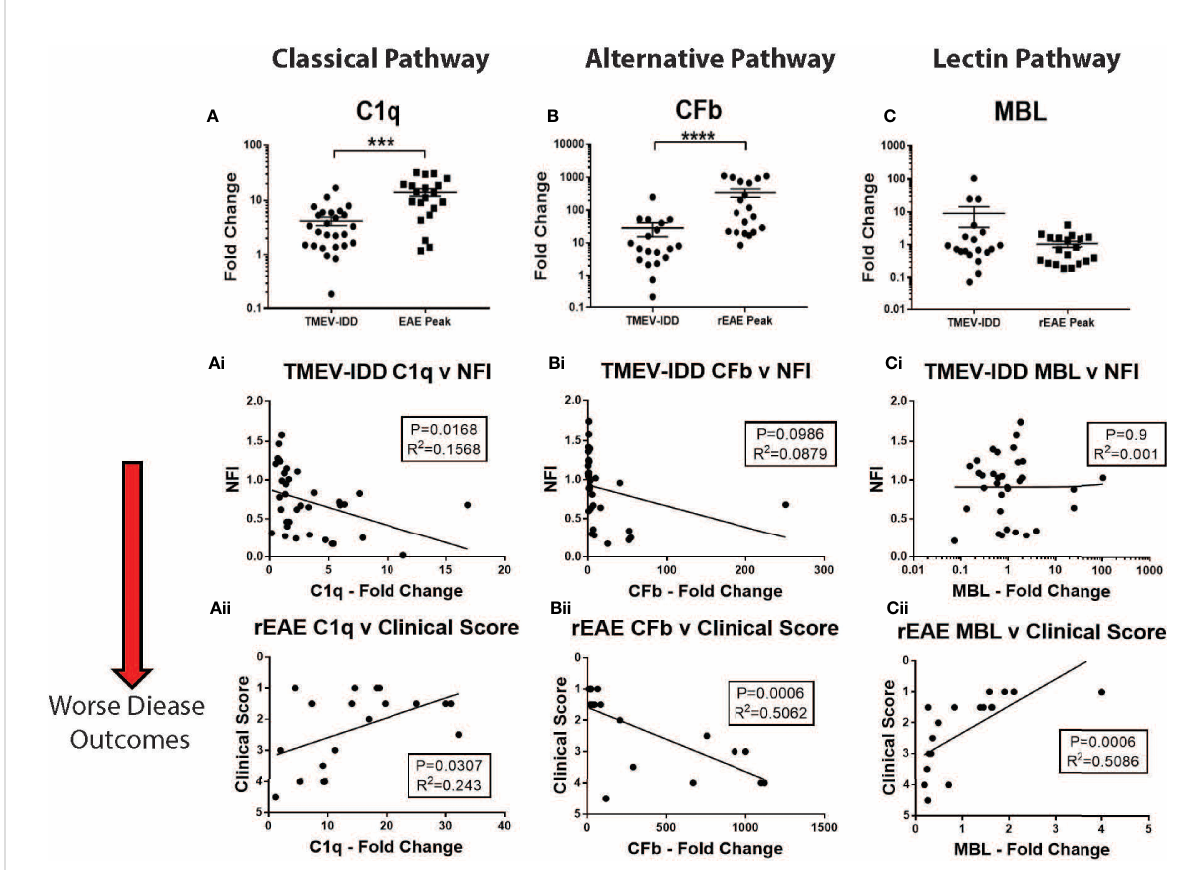
FIGURE 5 CNS gene expression of early complement components and their association with disease outcomes. Gene expression of C1q, CFb, and MBL was determined by rt-PCR in spinal cords from TMEV-IDD mice (n =26) at day ~120 post-infection or rEAE mice (n =20) at day ~15 post- immunization. (A – C) Scatter plots display C1q (A) , CFb (B) and MBL (C) in TMEV-IDD or rEAE mice with mean ± SEM for the group. Fold changes were calculated between diseased and age-matched sham mice. Signi fi cant differences are indicated by ****(P<0.0001) and *** (P<0.001) as determined by Mann-Whitney test. Linear regression analysis (Ai, Aii) shows that high C1q gene expression correlates with a worse disease outcome in TMEV-IDD (Ai), but an improved outcome in rEAE (Aii) . At the same time, CFb (Bi, Bii) relates to a worse disease outcome in rEAE, but not in TMEV-IDD. Finally, there is no signi fi cant correlation between CFb gene expression (Ci-Cii) and clinical outcome neither in TMEV-IDD nor in rEAE. Finally, high MBL gene expression (Ci, Cii) correlates with an improved clinical outcome in rEAE (Cii) , while no signi fi cant correlation is observed in TMEV-IDD (Ci) . P value and the coef fi cient of determination R 2 are indicated in each